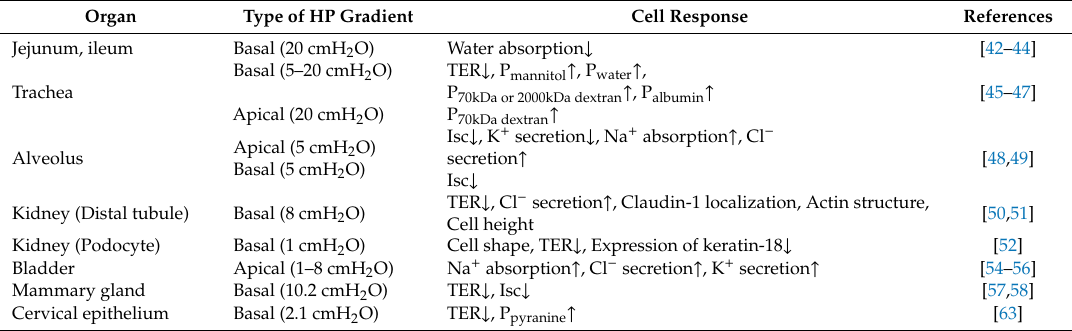
Table 2. E ff ects of the HP gradient on